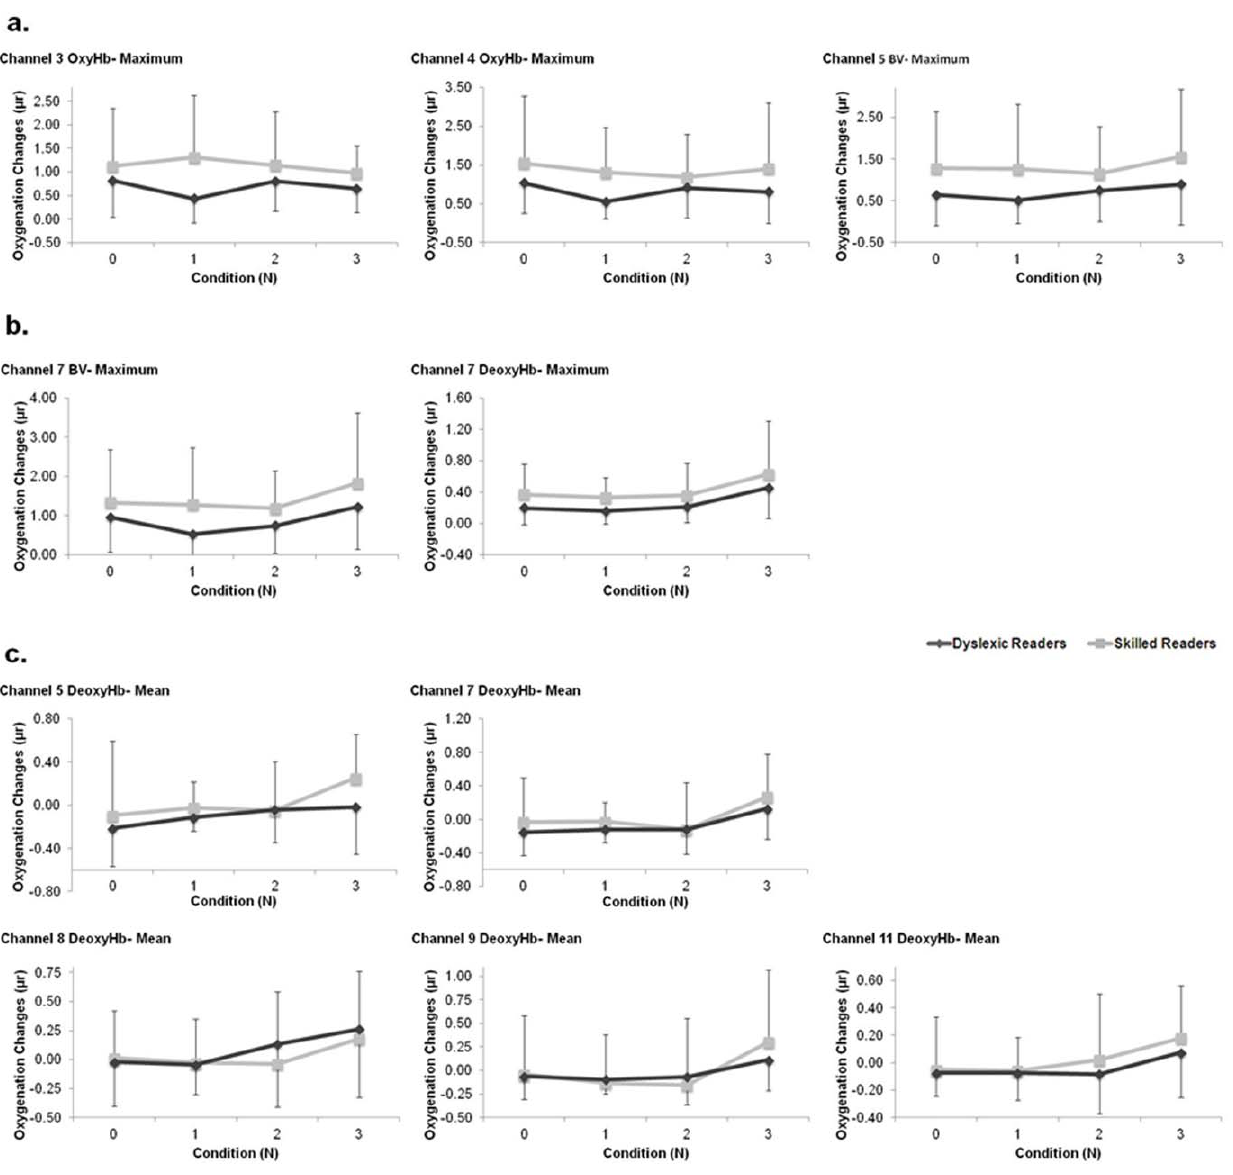
Figure 3. Significant fNIR-features of the dyslexic (dark line) and skilled (light line) readers. a) fNIR-features that showed significant between-group differences. b). fNIR-features that showed both significant group and task effects. c) fNIR-features that showed significant task. Error bars represent group’s standard deviation.